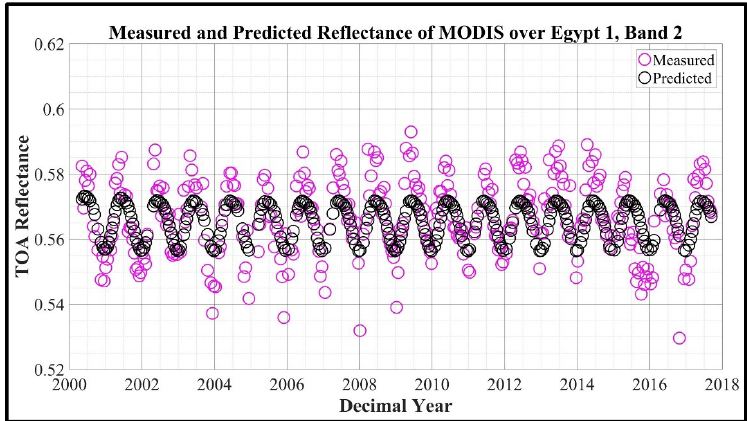
Figure 7. Terra MODIS observation of Egypt 1(magenta circle) NIR band and model prediction (black circle).